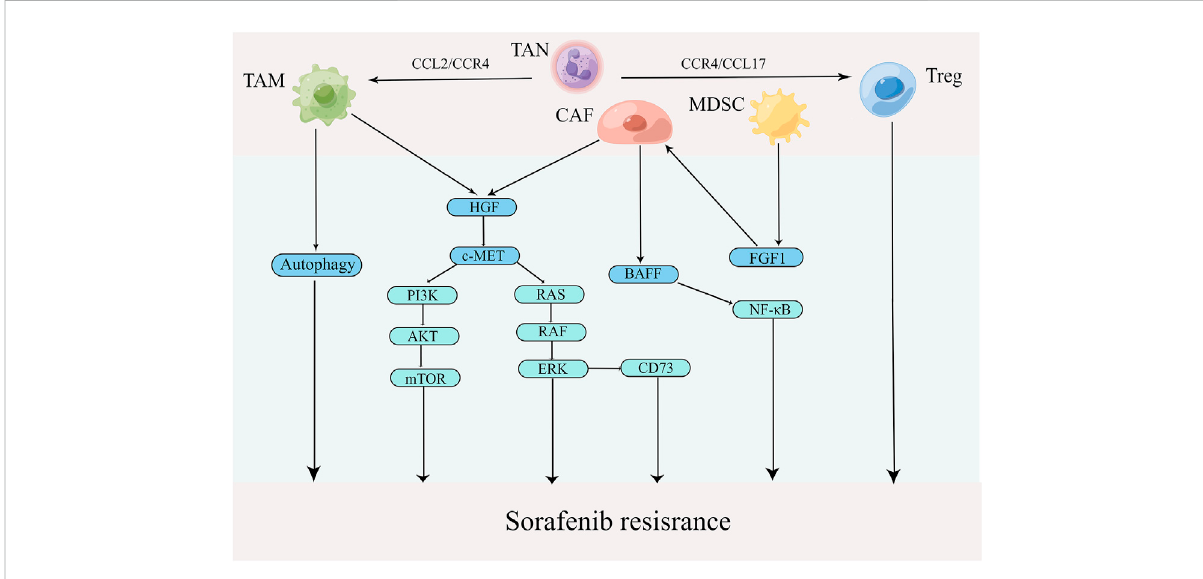
FIGURE 4 Mechanisms by which tumor-associated immune-suppressive cells promote sorafenib resistance in TME (edited by Figdraw